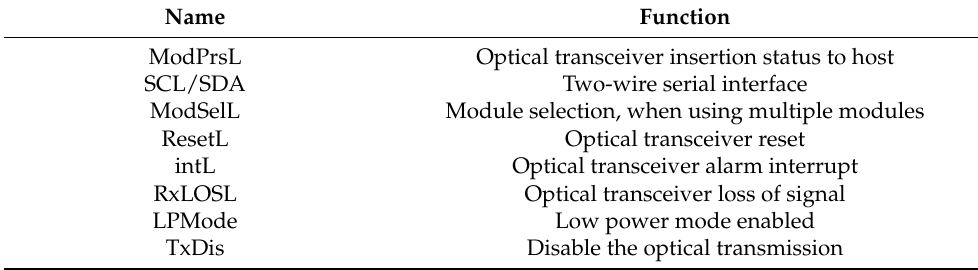
Figure 2. QSFP28 interface block diagram between host system and transceiver [16]. Table 2. Control and alarm signals with host connector for QSFP28